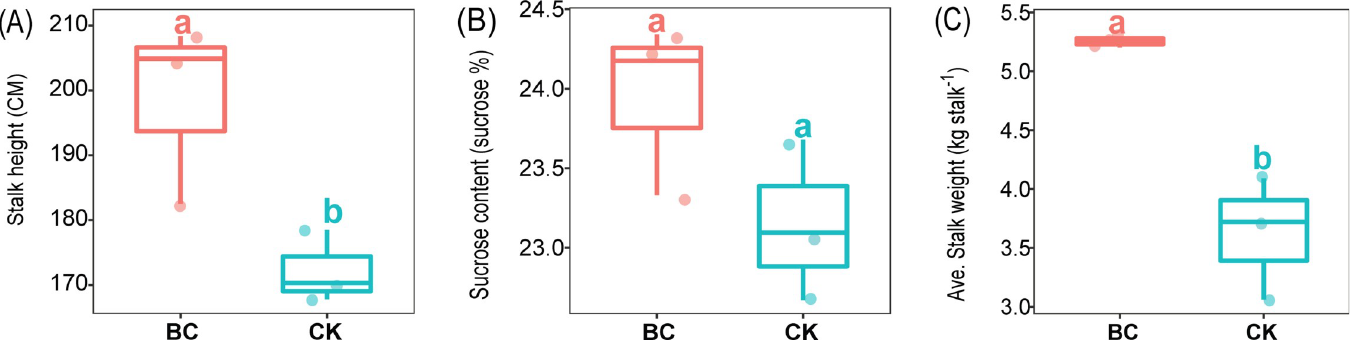
Fig 1. Impact of biochar amendment on sugarcane agronomic parameters. Boxplots with various lowercase letters indicate significant ( p < 0.05) differences between treatments based on Tukey’s HSD test. CK: Fertilization with N, P and K; BC: Fertilization with biochar.